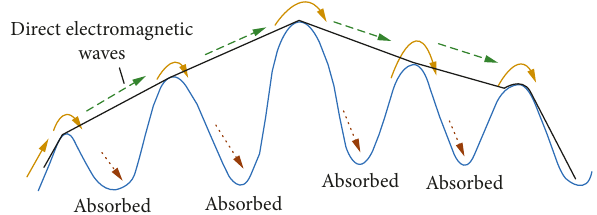
Figure 8: Schematic diagram of the link-peak diffraction model.